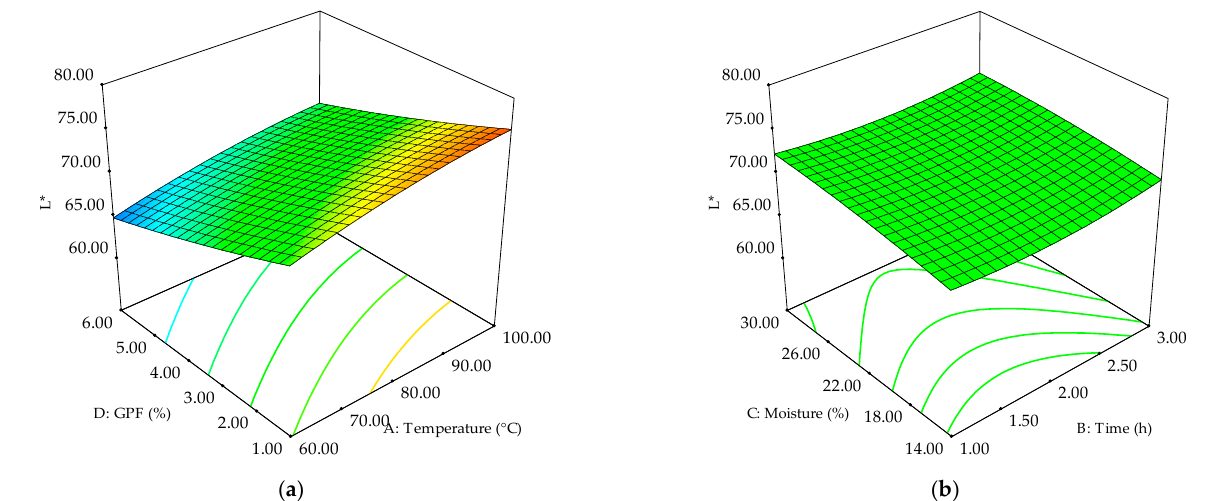
Figure 4. Three-dimensional response surface plots presenting the synergistic effects of factors: GPF level–temperature ( a ) and moisture-time ( b ) on dry pasta luminosity ( L* ).